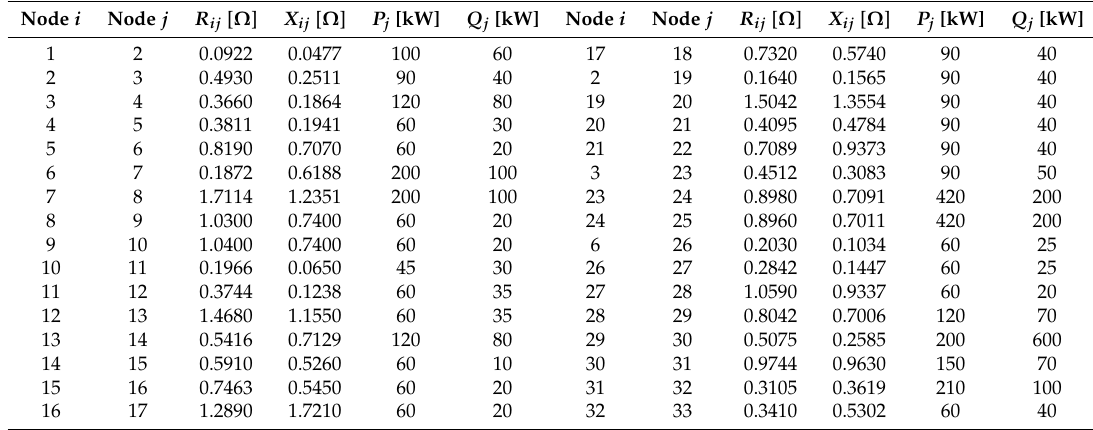
Table 3. Electrical parameters of the 33-node test feeder.